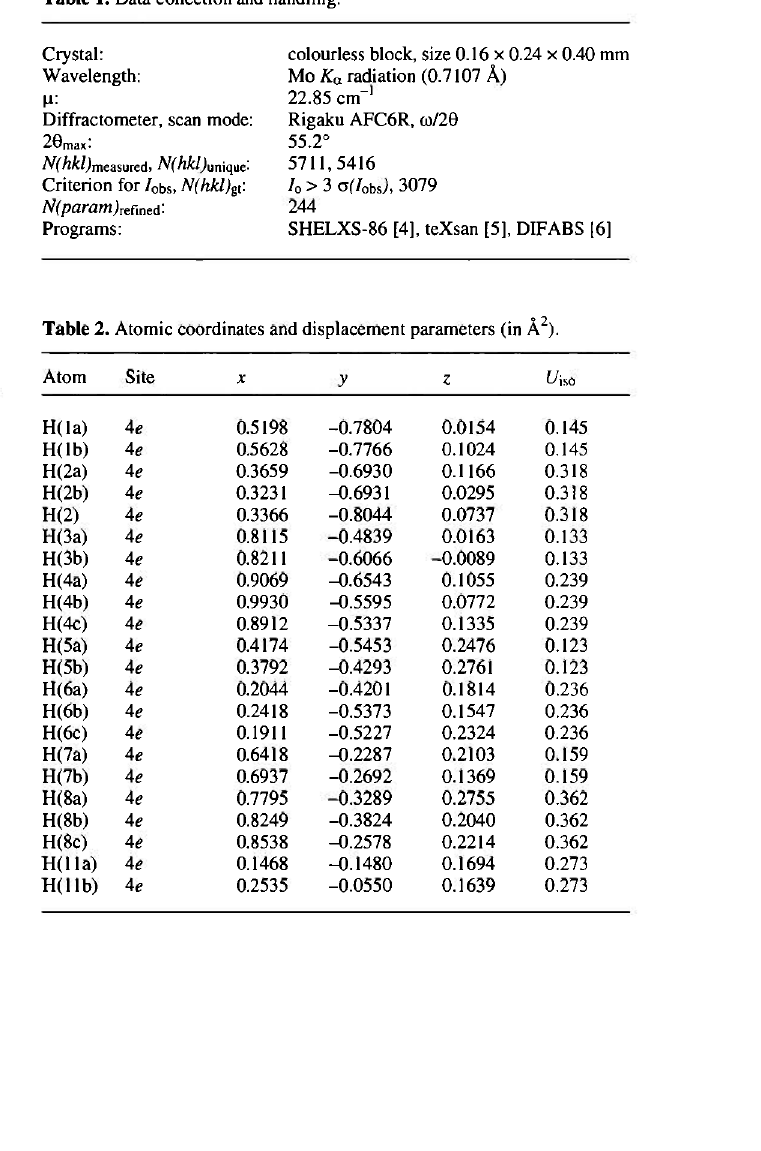
Table 1. Data collection and handling.